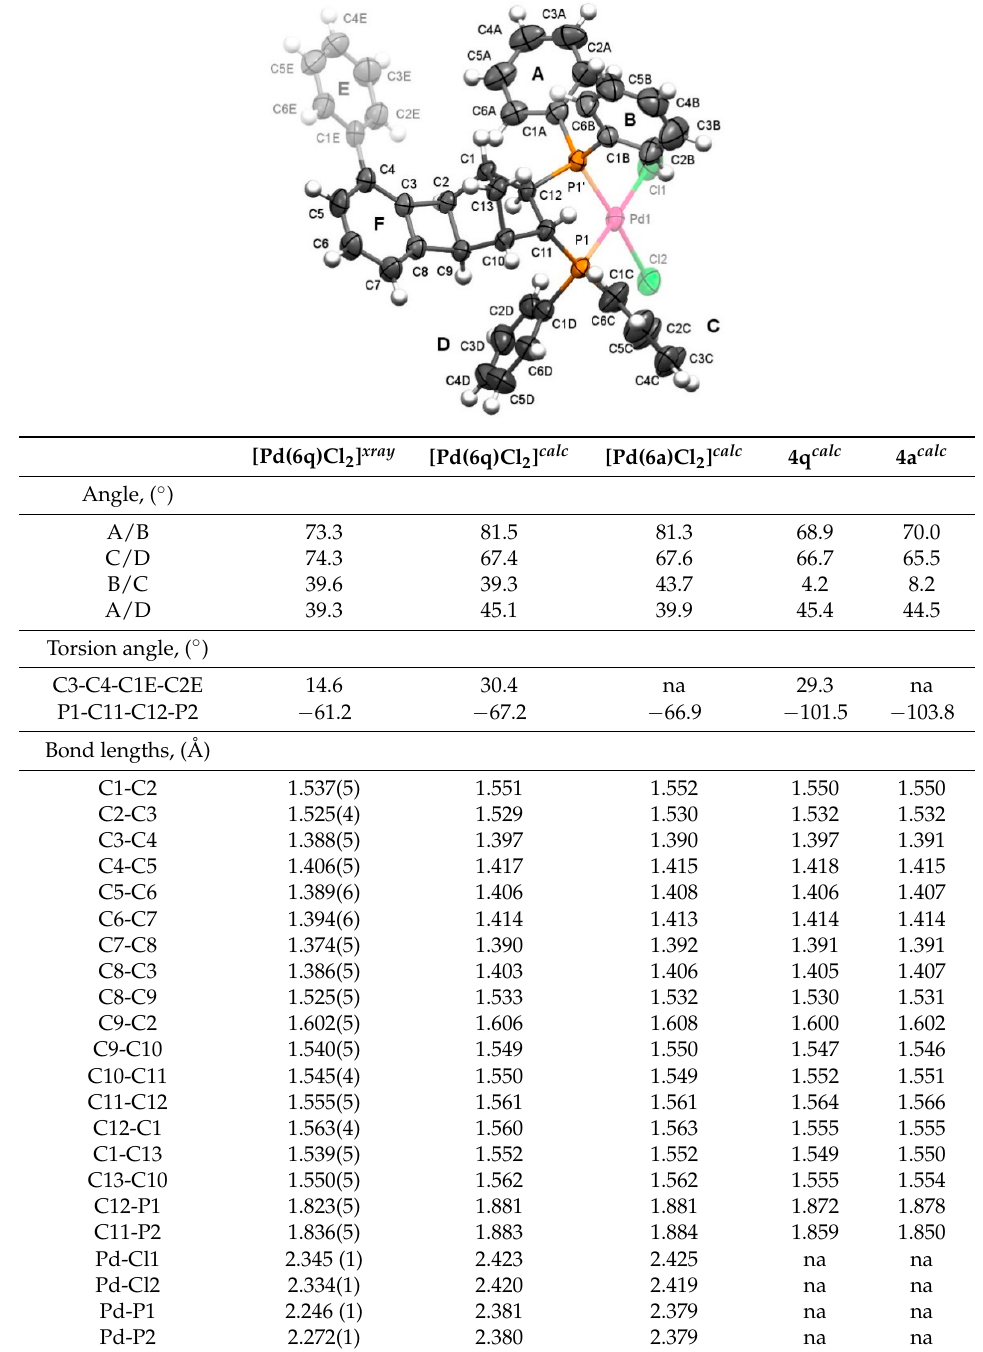
Table 6. Selected geometrical parameters of experimental and calculated [Pd( 6 )Cl 2 ] and 4.